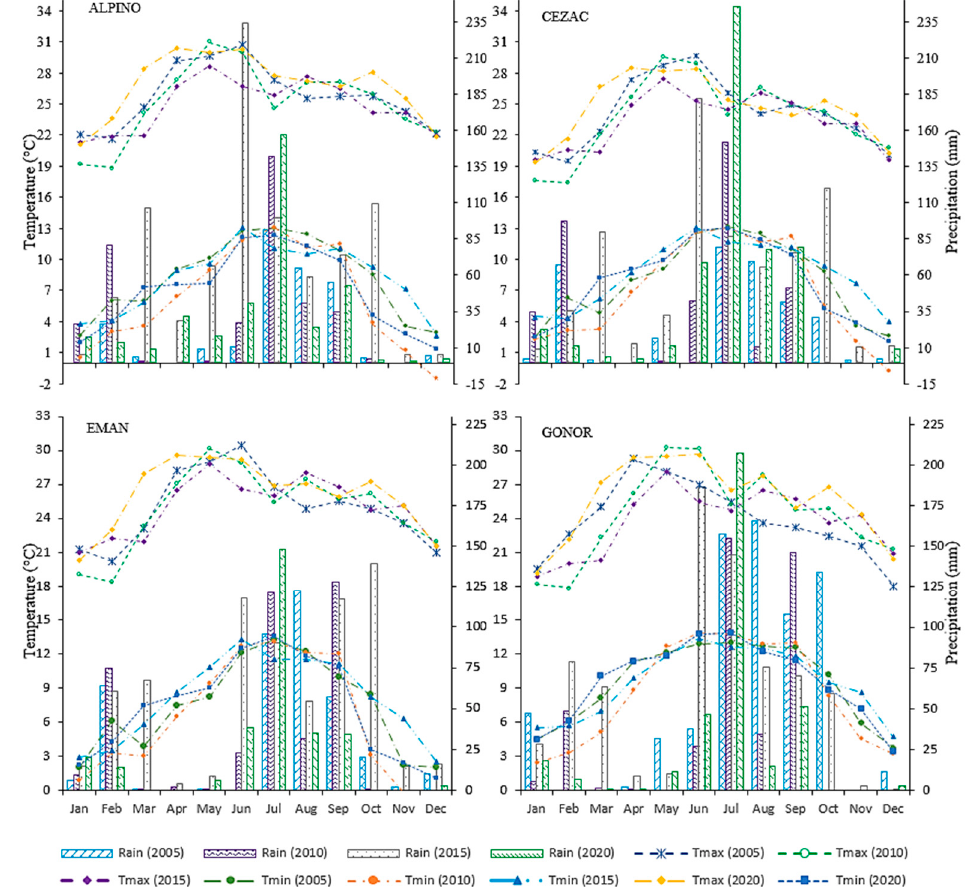
Figure 1. Climatic conditions of the four stations for the years 2005, 2010, 2015 and 2020.